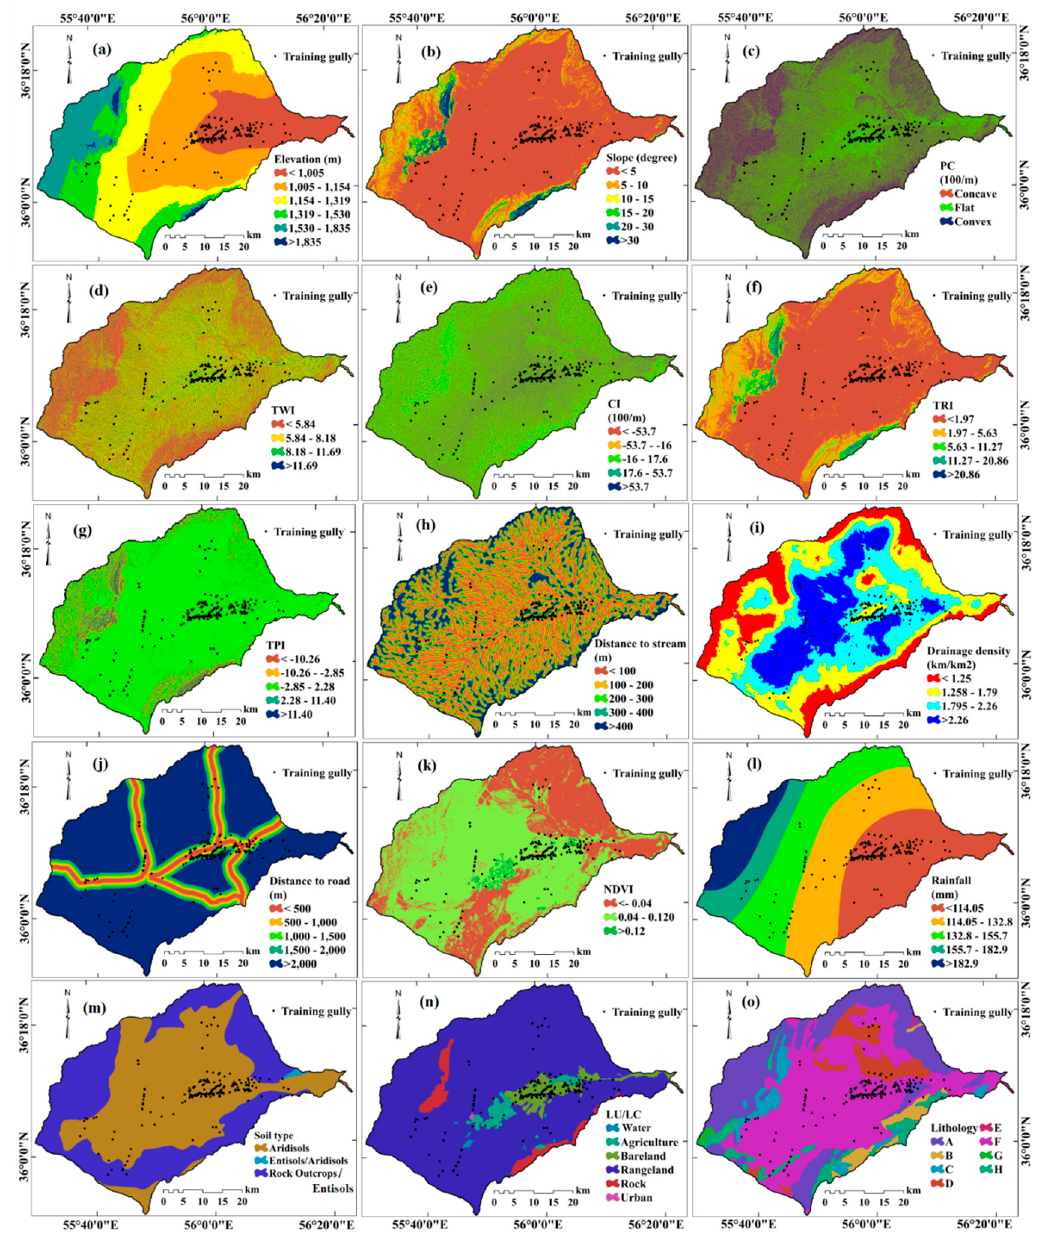
Figure 3. Gully erosion conditioning factors. ( a ) elevation, ( b ) slope, ( c ) plan curvature (PC), ( d ) topography wetness index (TWI), ( e ) convergence index (CI), ( f ) Terrain Ruggedness Index (TRI), ( g ) topography position index (TPI), ( h ) distance to stream, ( i ) drainage density, ( j ) distance to road, ( k ) Normalized Difference Vegetation Index (NDVI), ( l ) rainfall, ( m ) soil type, ( n ) land use/land cover (LU/LC), ( o ) lithology. Table 1. Classes and classification method for the various thematic data layers.